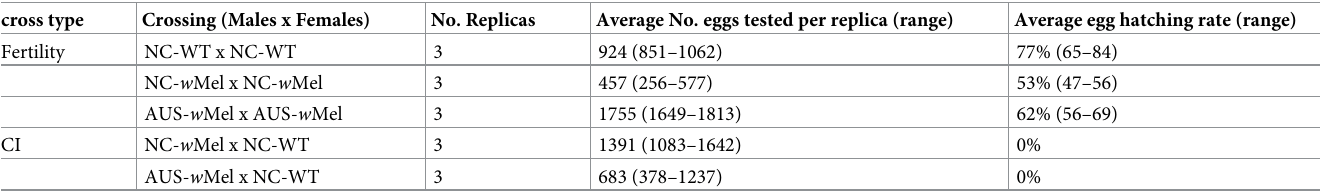
Table 4. Average egg hatching rate from fertility and CI crosses. cross type Crossing (Males x